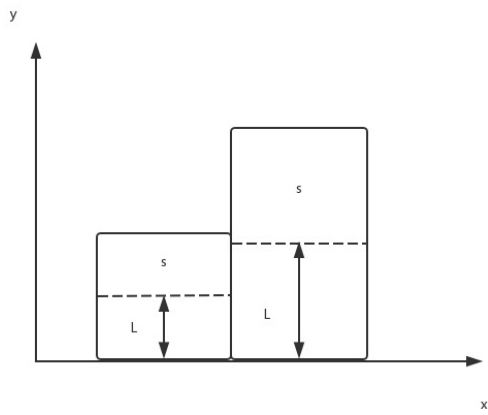
Fig. 1 Area of center of gravity design